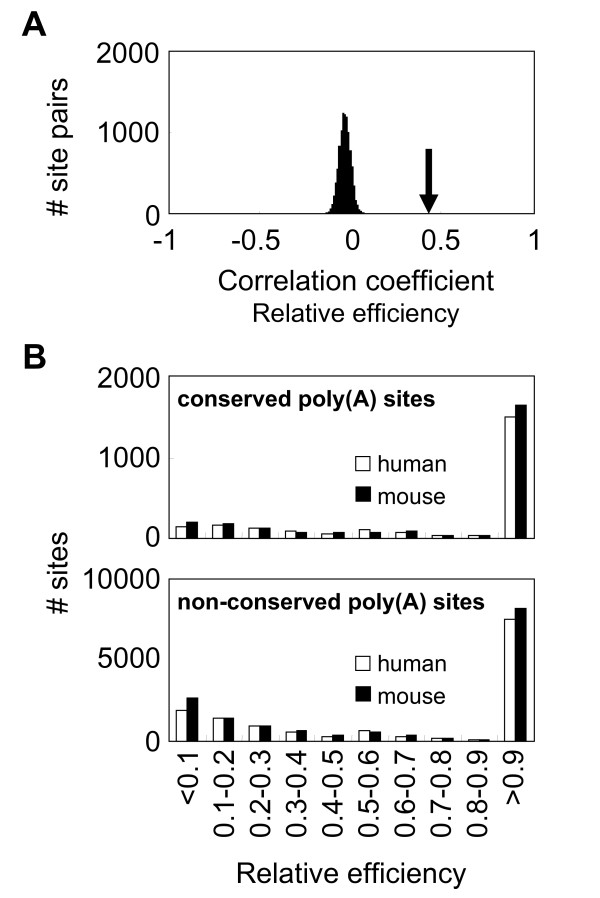
Relative efficiency of conserved and non-conserved polyadenylation sites. (A) Distribution of 10,000 control correlation coefficients each computed from 1000 random pairs of non-conserved sites from orthologous human and mouse genes. Arrow indicates the correlation coefficient observed for pairs of conserved sites (r = 0.45). (B) Distribution of relative efficiency of conserved and non-conserved polyadenylation sites. Number of sites in human (white) and mouse (black) is plotted against relative efficiency.